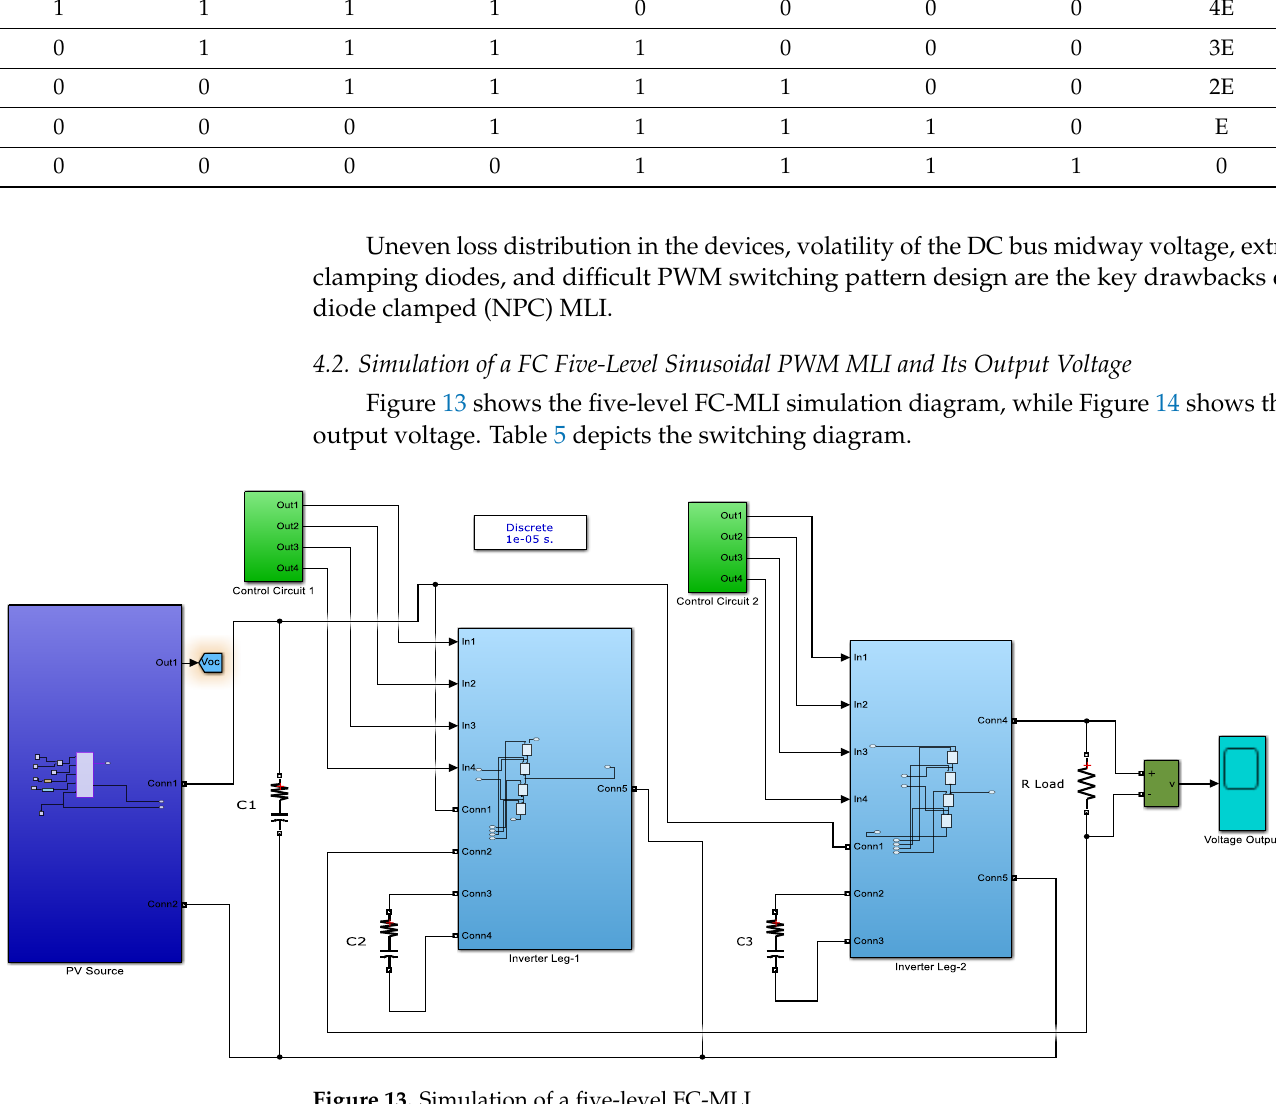
Figure 13. Simulation of a five-level FC-MLI .